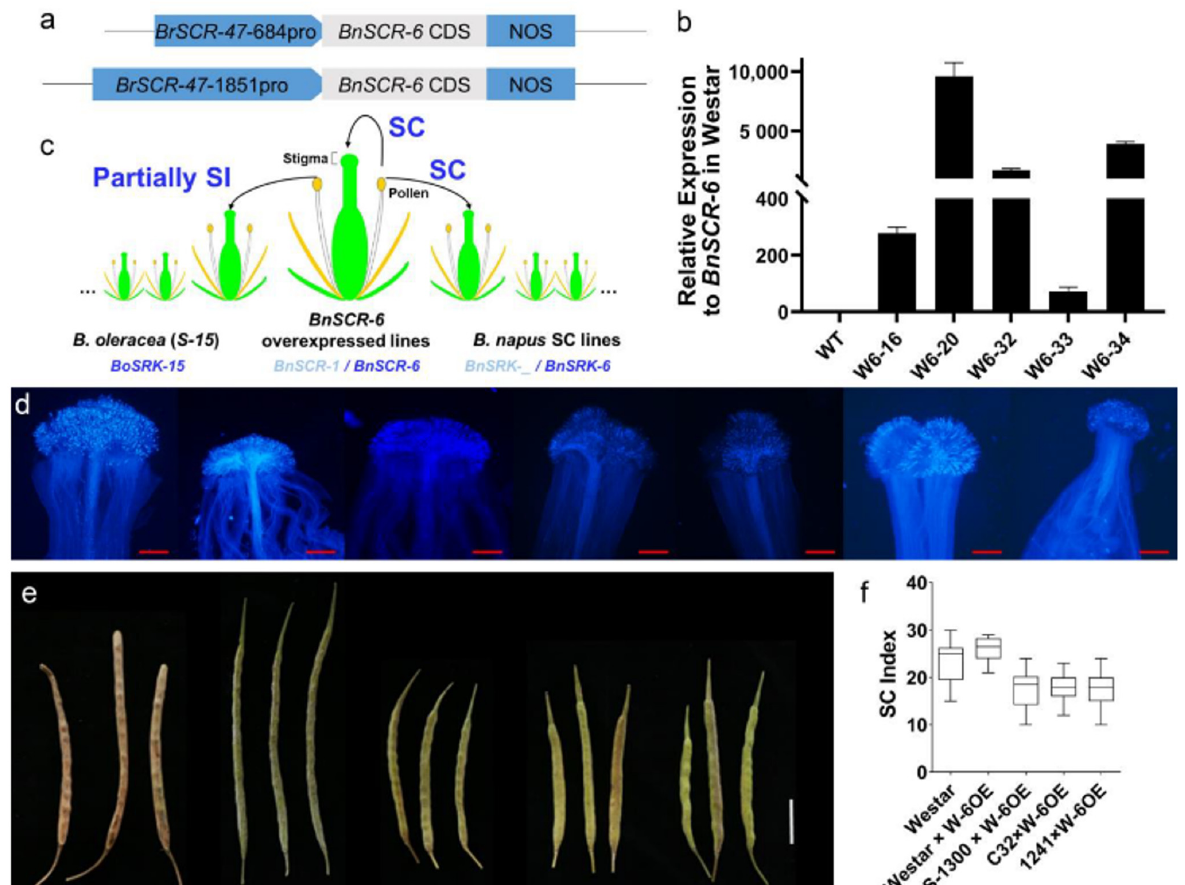
Figure 4. Pollination test of BnSCR-6 overexpression lines. ( a ) Overexpression of BnSCR-6 vector diagram. ( b ) BnSCR-6 expression level detection in T 0 generation. ( c ) Pollination pattern diagram. ( d ) Typical pollen tube germination in T 2 generation, left to right: Westar, ‘Westar × We-6OE, S-1300 × We-6OE, C32 × We-6OE, 1241 × We-6OE, Gan-64 × We-6OE, Gan-118 × We-6OE. Gan-64 and Gan-118 is the B. oleracea material with S-15 , Bar = 500 µ m. ( e ) The corresponding siliques in Figure d, left to right: Westar, Westar × We-6OE, S-1300 × We-6OE, C32 × We-6OE, 1241 × We-6OE. Due to the poor seed-setting ability of B. oleracea itself, the hybrid siliques develop abnormally, Bar = 2 cm. ( f ) The SCI statistics of pollination tests in ( e